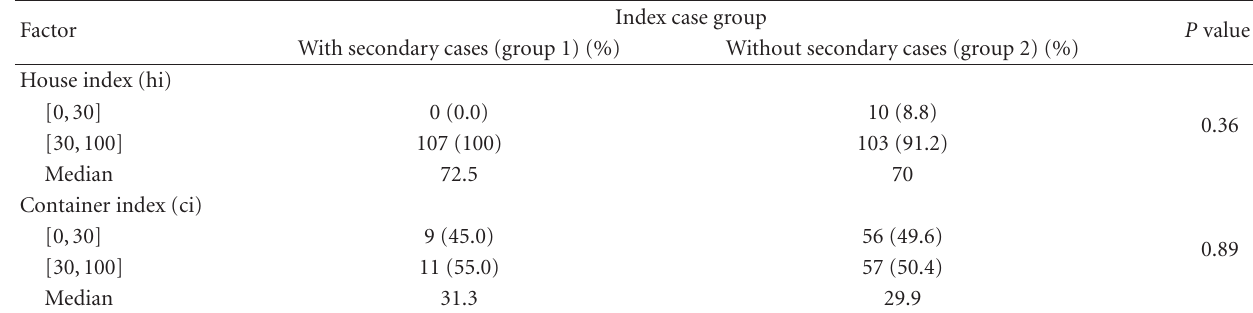
Table 4: Comparison of house and container